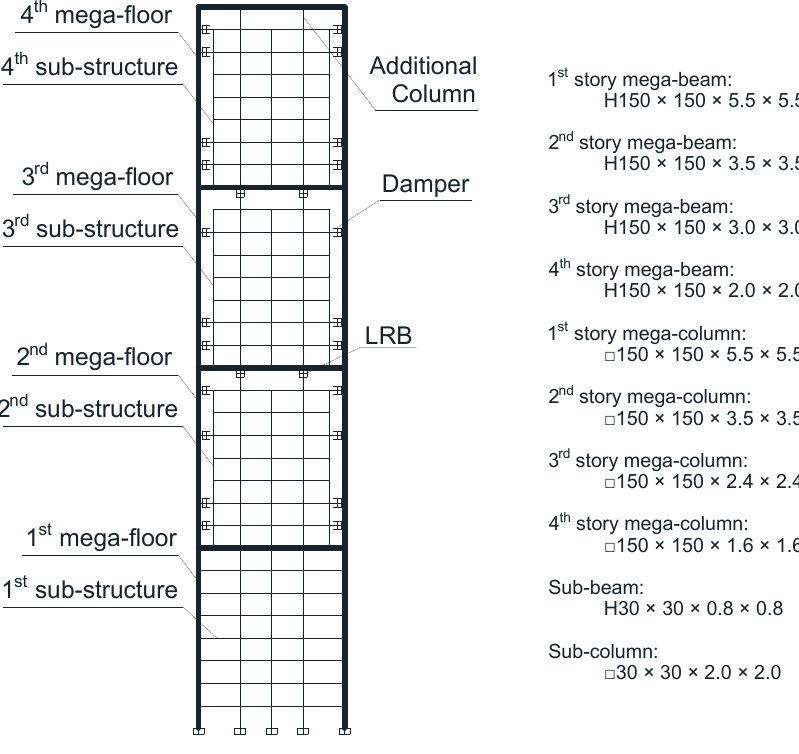
Figure 5. Finite element model of MSCSS with LRBs.